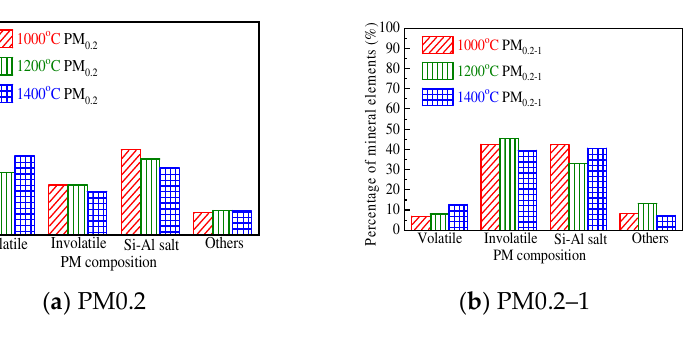
Figure 4. Composition of various size fractions of coal ash generated at different combustion tem- peratures. Volatile denotes Na, K, and S; non-volatile denotes Mg, Ca, and Fe.